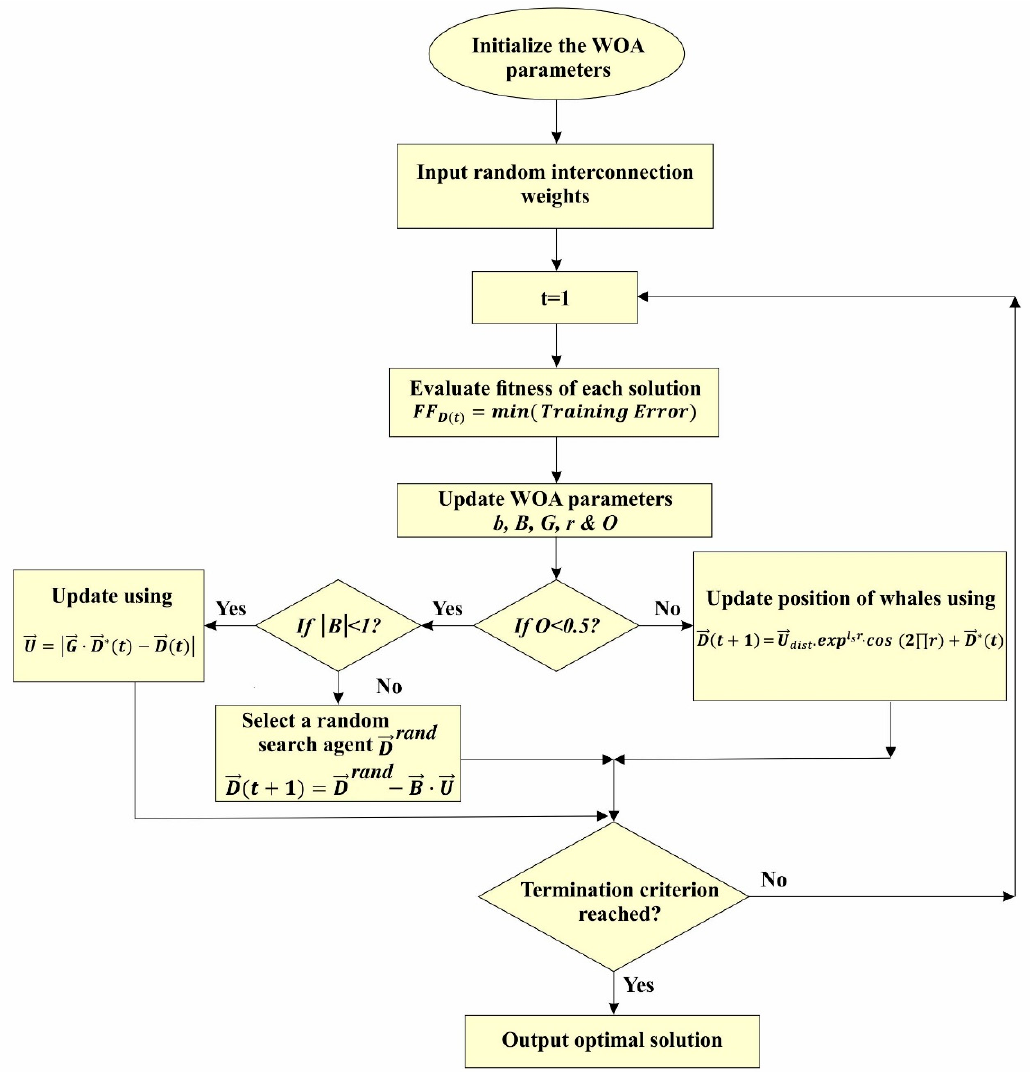
Figure 2. Flowchart of whale optimization algorithm for optimally selecting the weight of neurons in the reservoir layer.